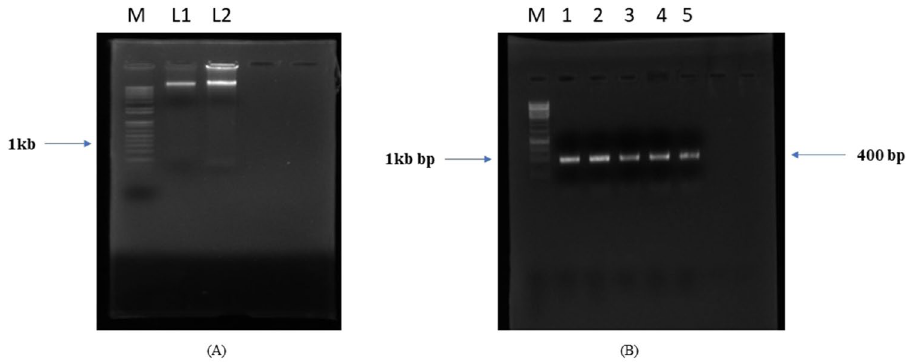
Figure 1. ( A ) represents M; 1 kb Marker, L1 and L2 (gDNA replicates), and ( B ) represents M; 1 kb Marker, 1,2,3,4 and 5; Amplicon replicates (~ 400 bp).